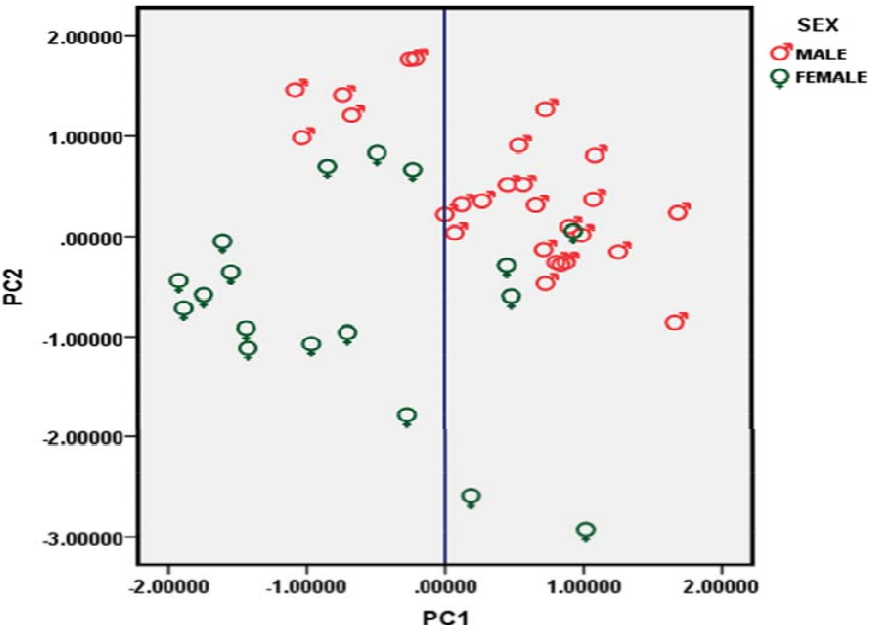
F IGURE 3 . The scatter plot resulted from the PCA analysis to showing sexual dimorphism in Trapelus r. ruderatus . Note the relative degree of isolation of males and